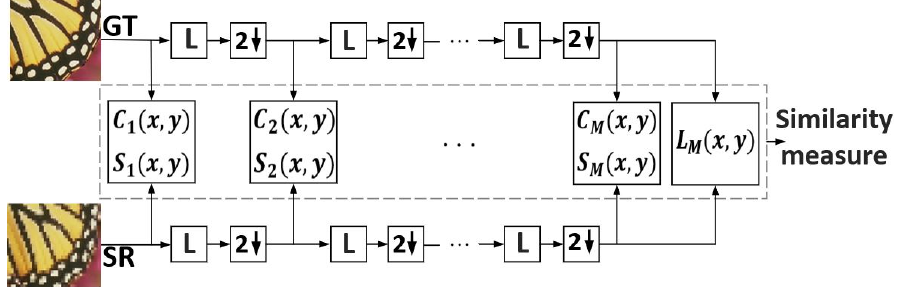
Figure 6. Block diagram of